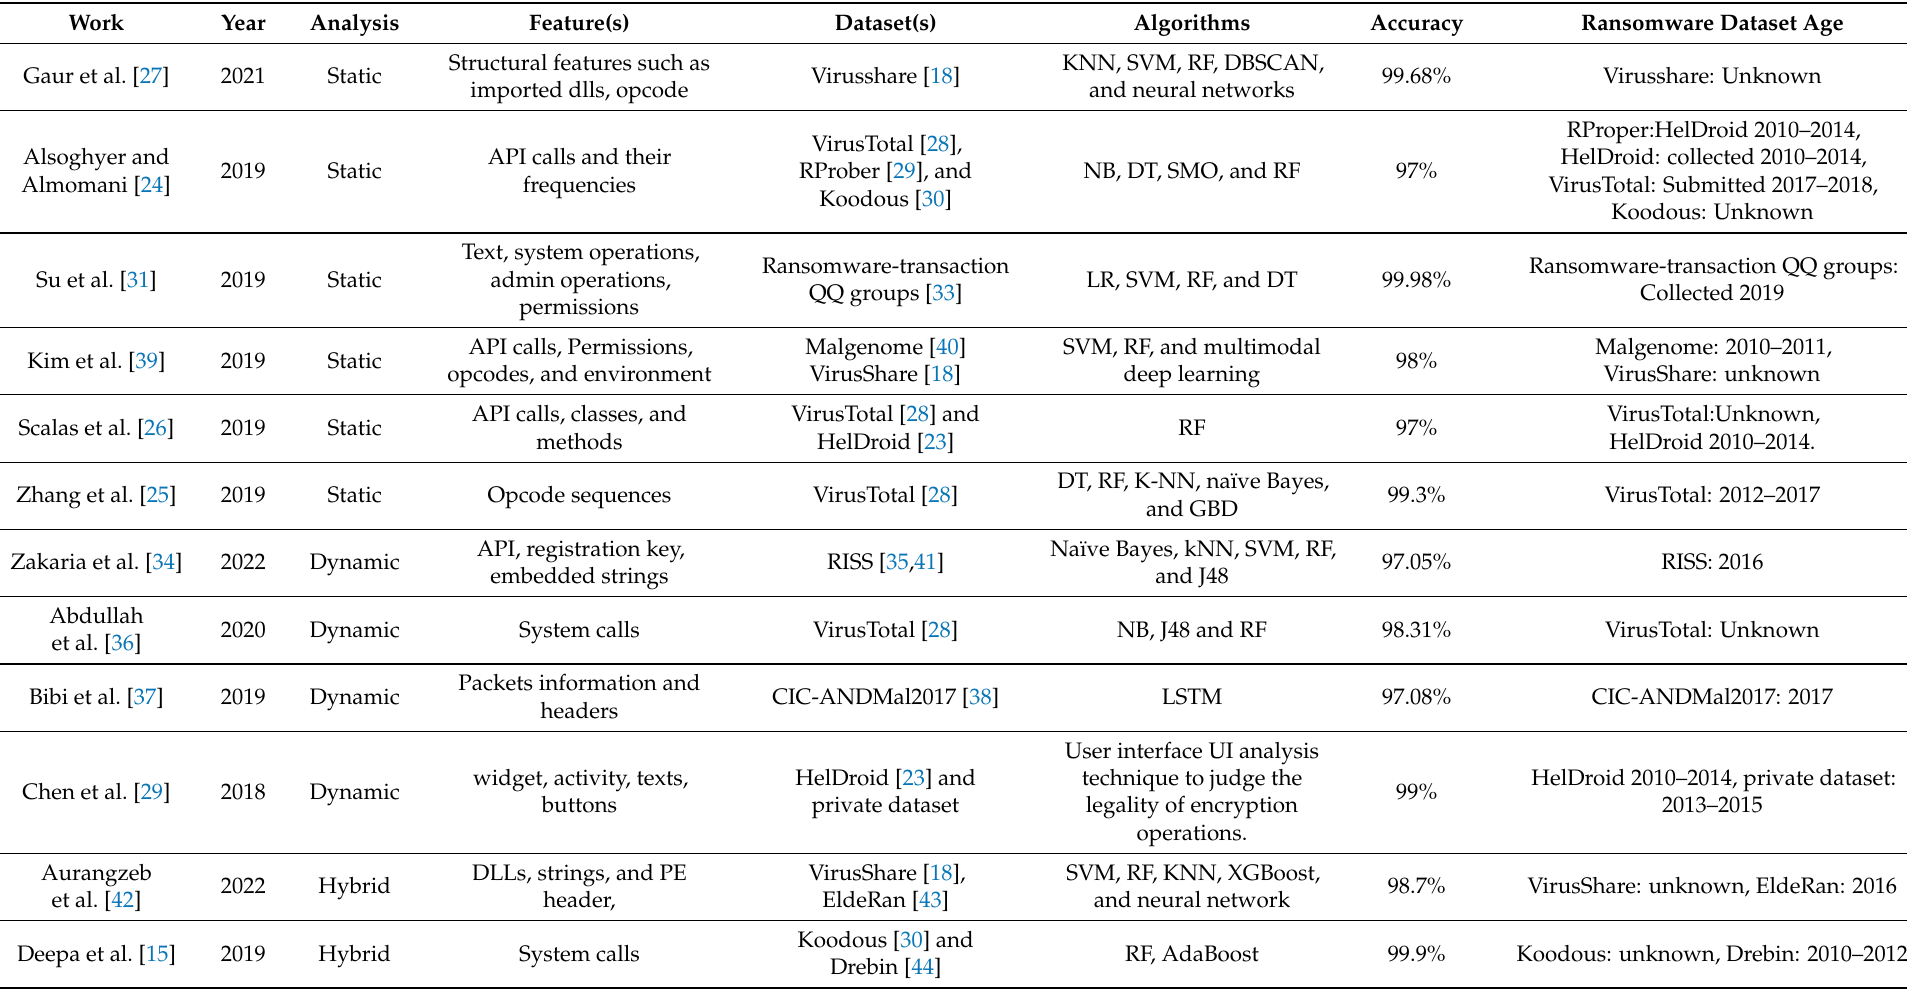
Table 2. A comparison between some related